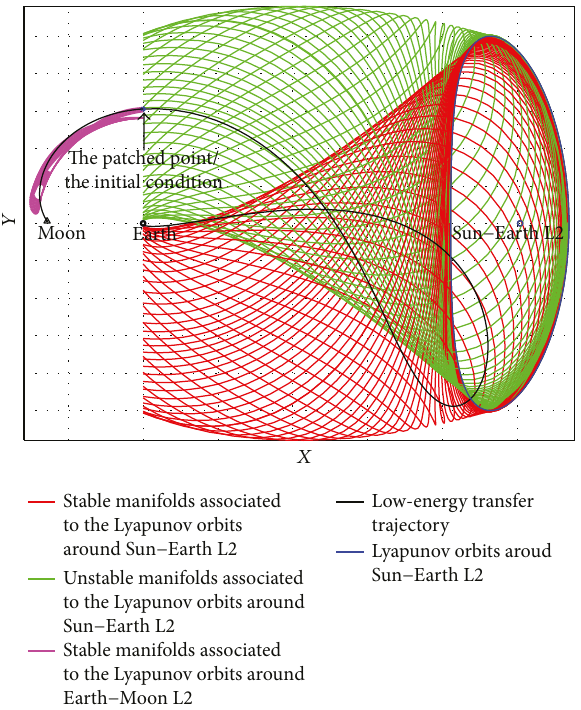
Figure 2: The manifolds and the low-energy transfer trajectory in the rotating